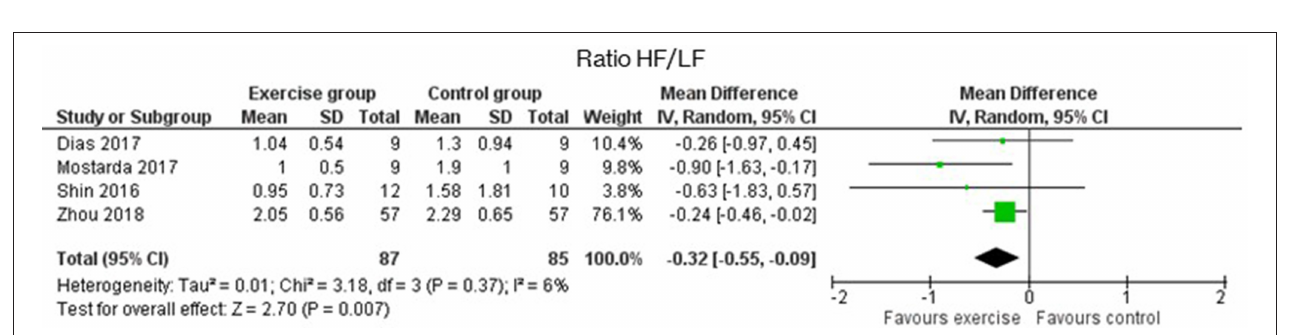
FIGURE 6 | Effects of exercise in Ratio HF/LF (ratio of Low Frequency to High Frequency) heart rate variability